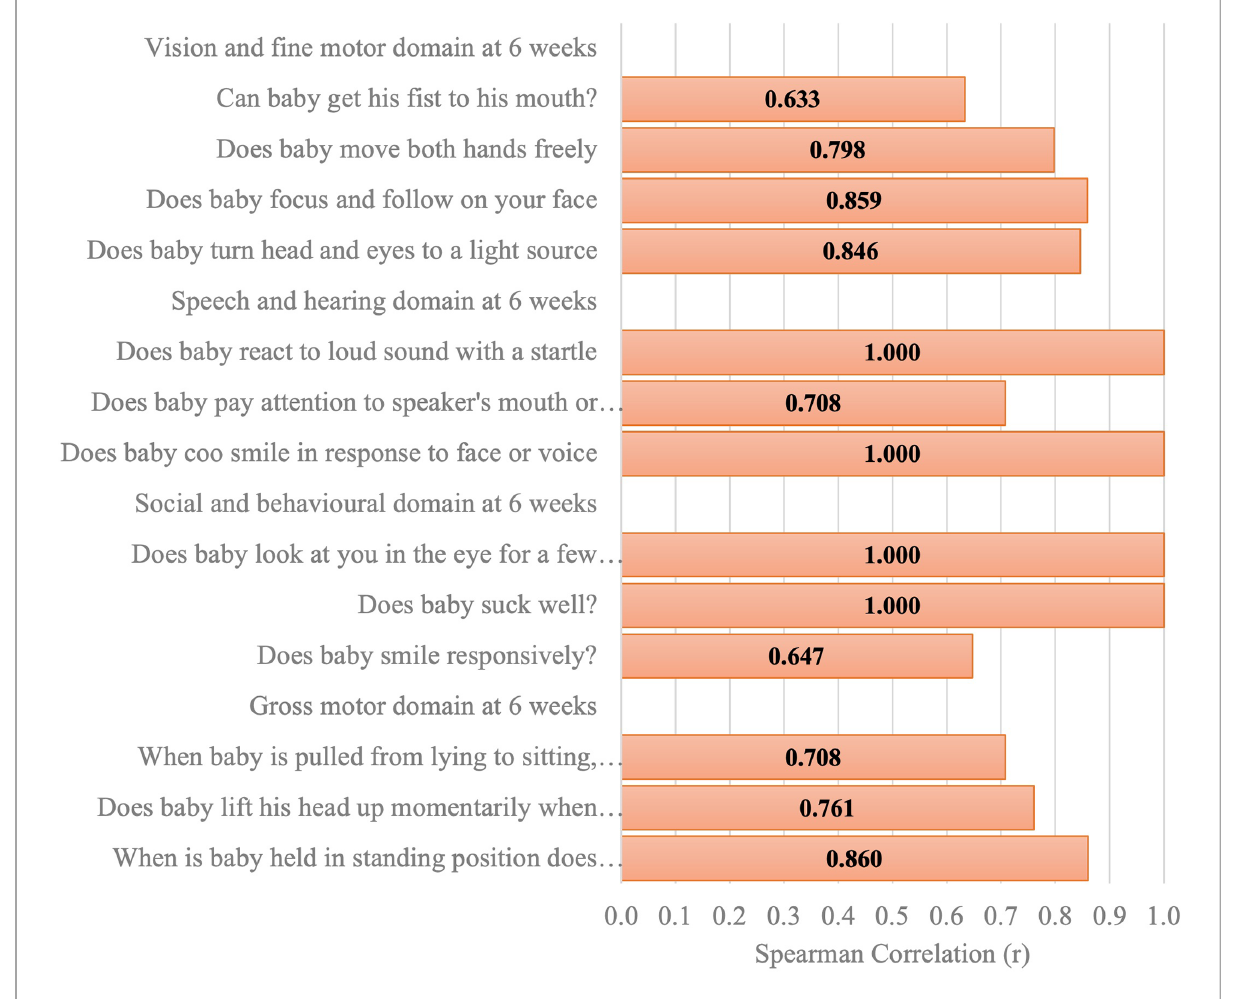
FIGURE 6 Spearman correlation coef fi cient of the ISDS scores of two assessors of the same participants aged 6